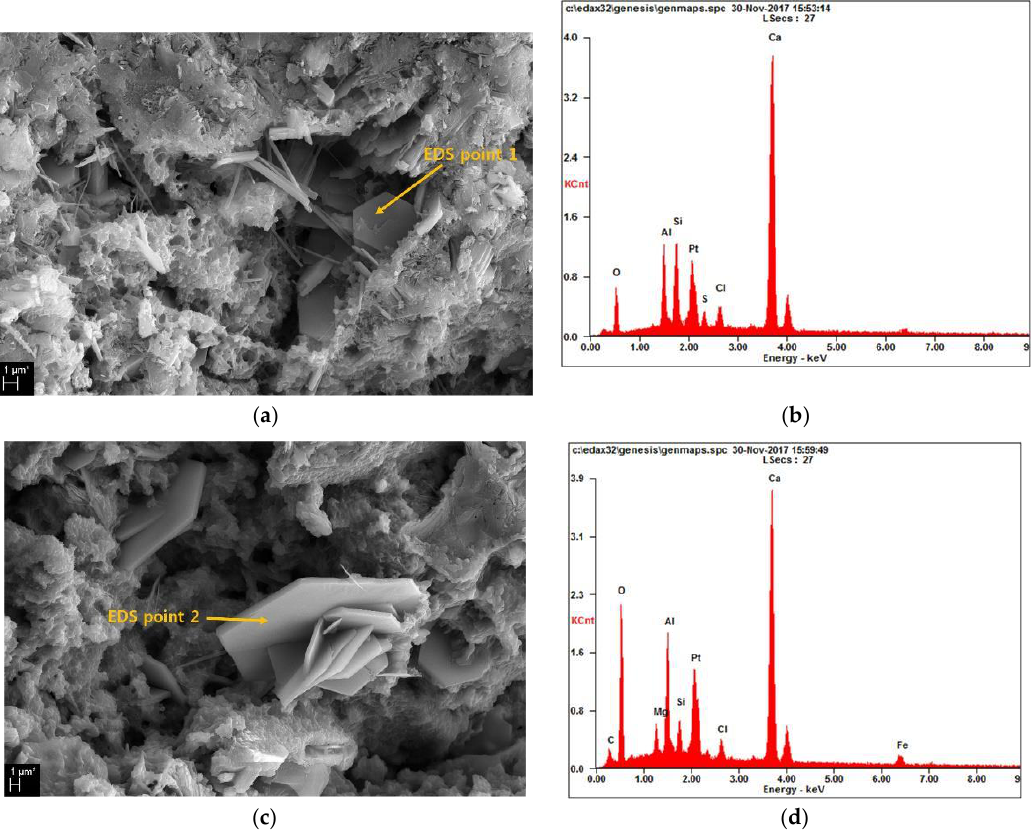
Figure 6. SEM images ( a ) Friedel’s salt (hexagonal plates) with 6% PACl. ( b ) Results of energy dispersive spectroscopy (EDS) analysis at “EDS point 1” shown in panel ( a ). ( c ) Friedel’s salt with 10% PACl. ( d ) Results EDS analysis at “EDS point 2” shown in panel ( c ).